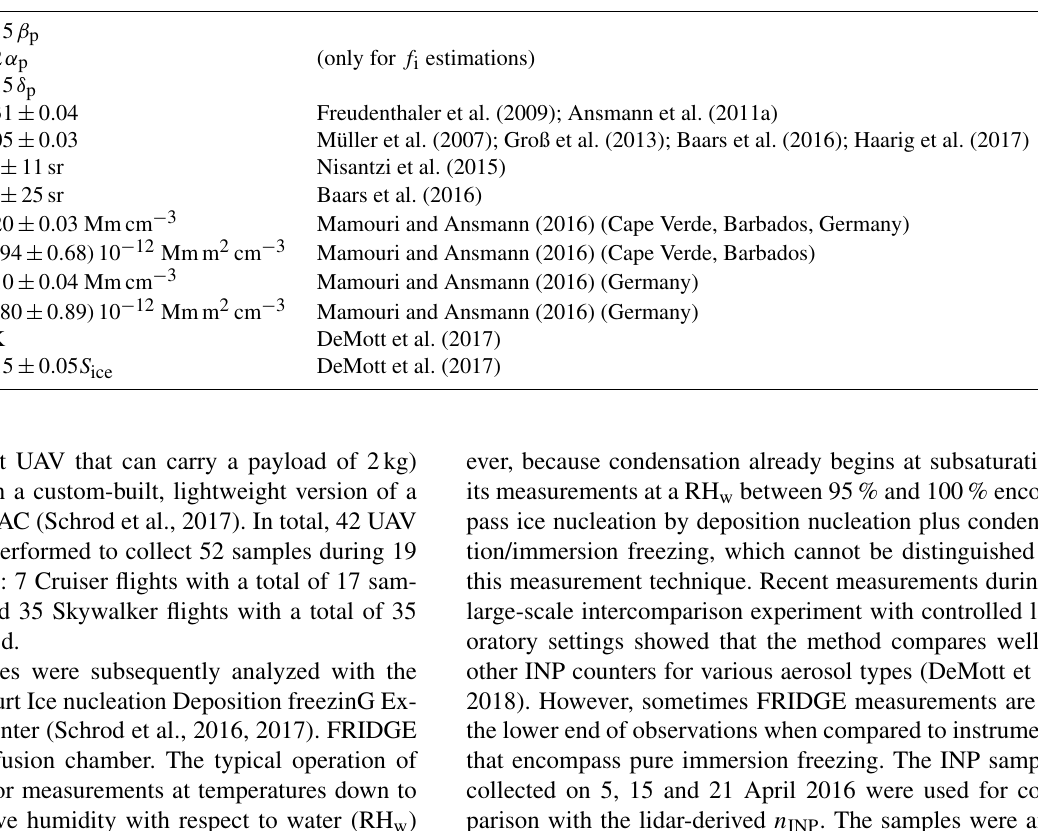
Figure 2. PollyXT profiles of the total particle backscatter coefficient (purple) and particle linear depolarization ratio (green) measured between 01:00 and 02:00UTC on 21 April 2016. The extinction coefficient as well as the number and surface concentration of particles with a dry radius larger than 250nm related to mineral dust (orange) and nondust aerosol (black) was obtained following the methodology described in Sect. 3.2. Table 2. Values and typical uncertainties used for the estimation of f i , α d , α c , S d , dry , S c , dry , n 250 , d , dry , n 250 , c , dry and n INP .